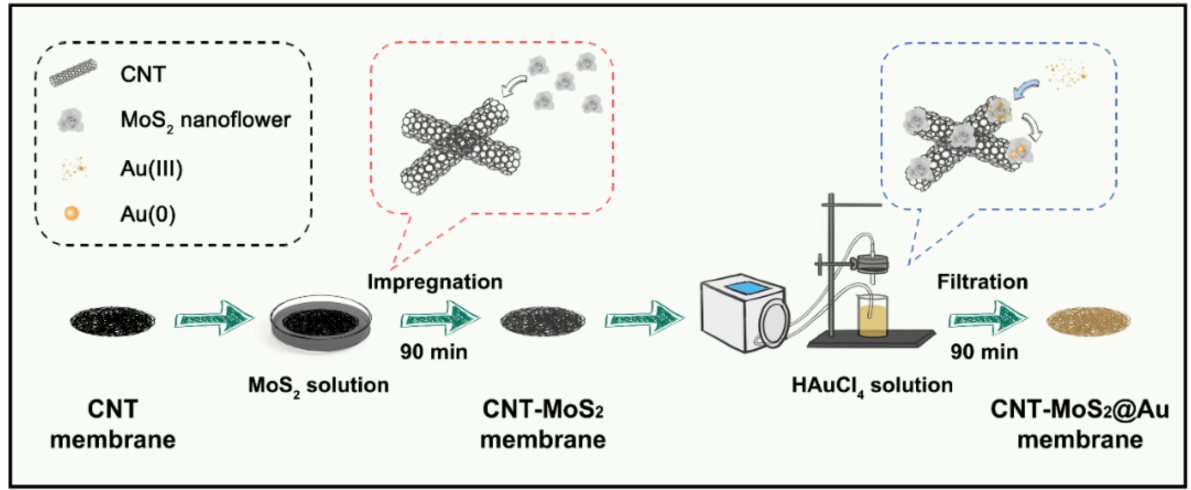
Figure 1. Schematic illustration for the synthesis of the CNT-MoS 2 @Au catalytic